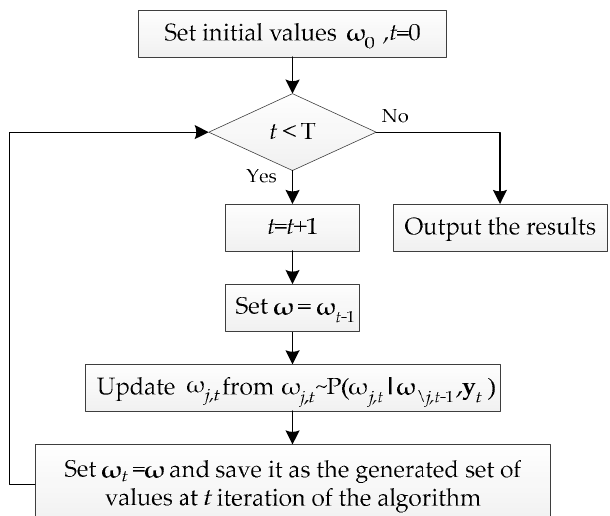
Figure 4. Gibbs sampler algorithm.